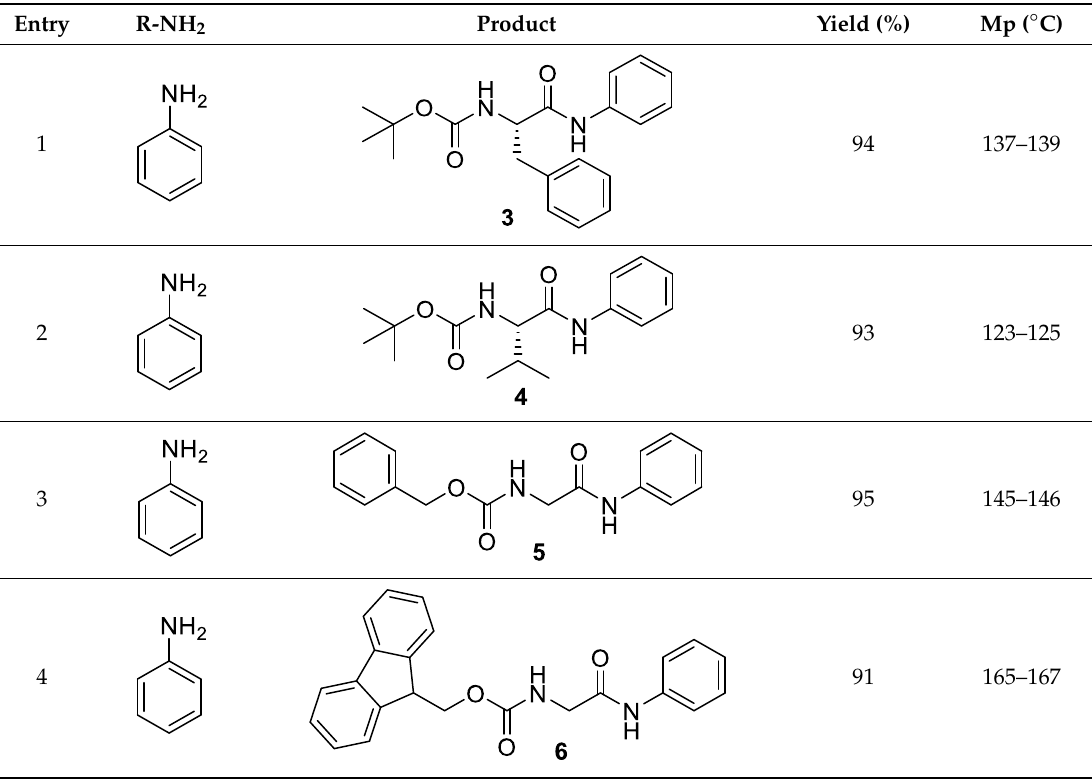
Table 2. Preparation of N -acylated amines.